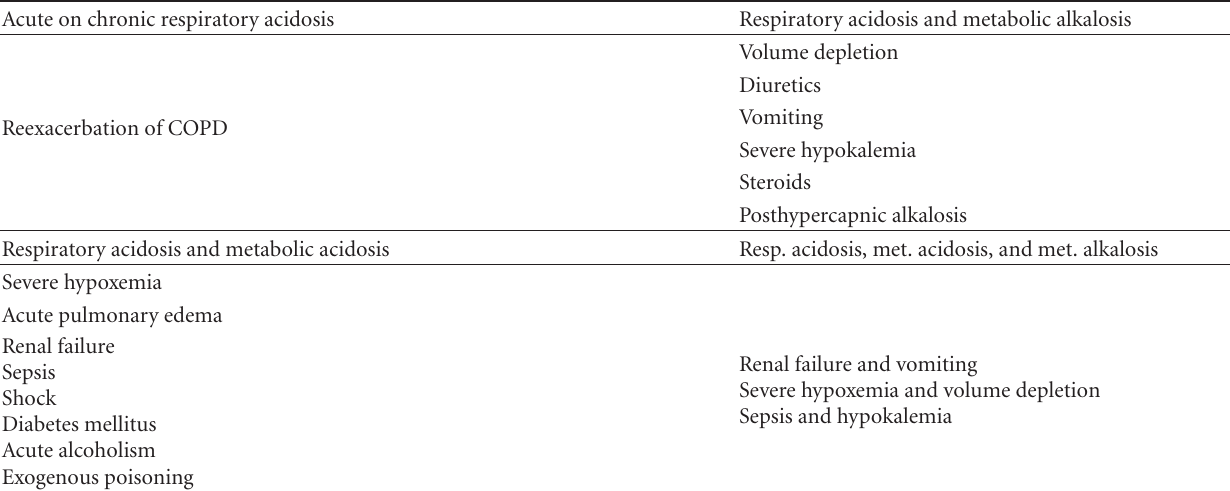
Table 1: Mixed acid-base disturbances in